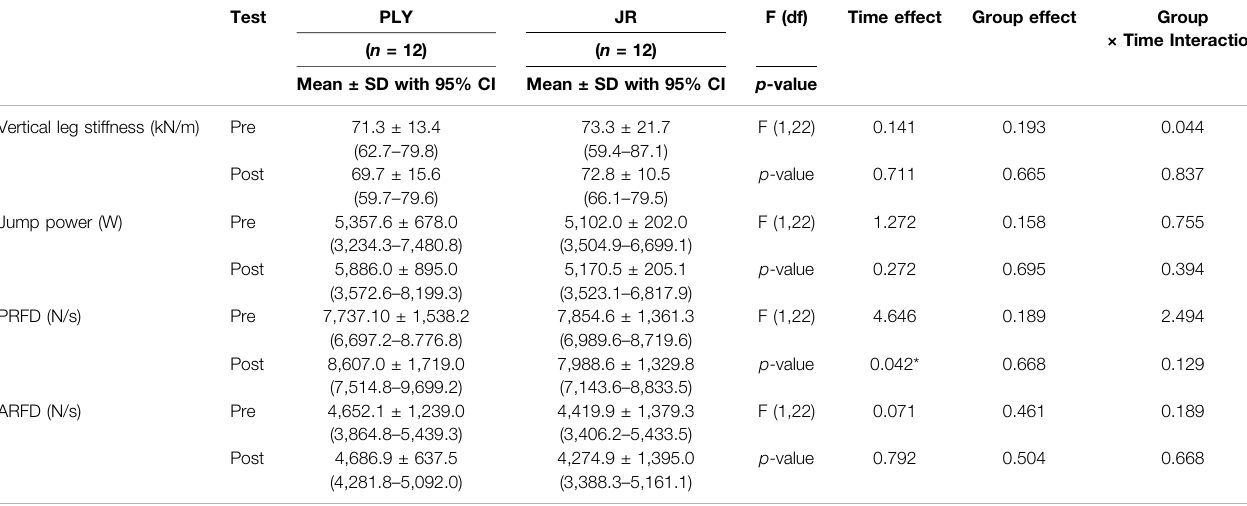
TABLE 6 | Biomechanical characteristics of countermovement jump before and after PLY or J.R.